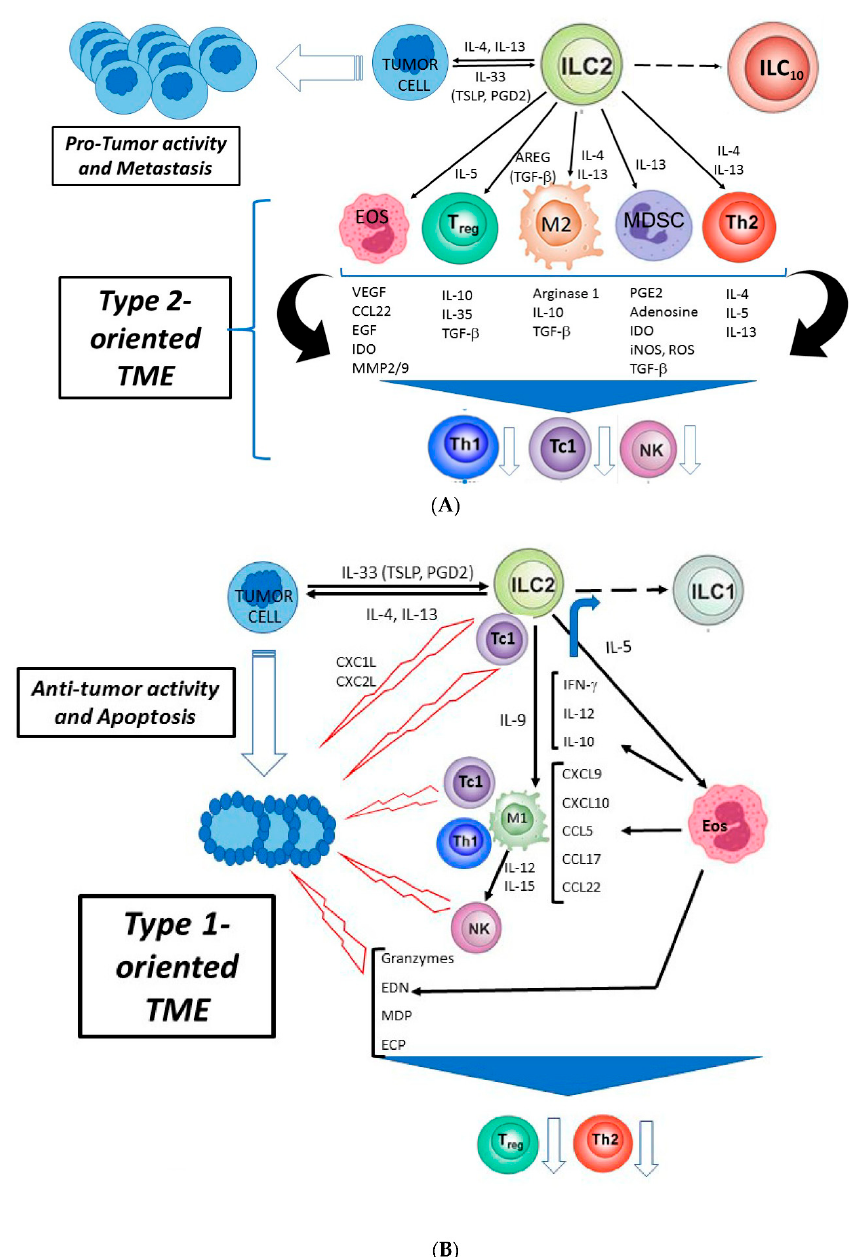
Figure 1. Opposite e ff ects of group 2 innate lymphoid cells (ILC2s) on tumor burden. ( A ). Protumor activity of ILC2s: ILC2s interact with TME- and tumor cells by recruiting and amplifying cells of type 2 inflammation which favor tumor growth and metastasis. ( B ). Antitumor activity of ILC2s: ILC2s interact with TME- and tumor cells by recruiting and activating eosinophils, macrophages with M1 profile and other cells of type 1 response (CD8 + T cells) and molecules (CXCL1L / CXCL2L) promoting the lysis / apoptosis of tumor cells. These opposite e ff ects of ILC2s on tumor burden depend on the distribution, di ff erentiation and plasticity of ILC2s in di ff erent tissues, the tumor histology, the TME signals activating ILC2s, the prompt and variable expression of signals (surface molecules and cytokines) activating the e ff ector or regulatory cells of innate and adaptive immunity. AREG: amphiregulin, Eos: eosinophils, ILCs: innate lymphoid cells; ILC 10 : IL-10-producing ILCs; MDSC: myeloid-derived suppressor cells, M1, M2: functional profiles of tumor-associated macrophages, Tc: cytotoxic CD8 + T cells; Th: T helper cells; TME: tumor microenvironment; Treg: regulatory T